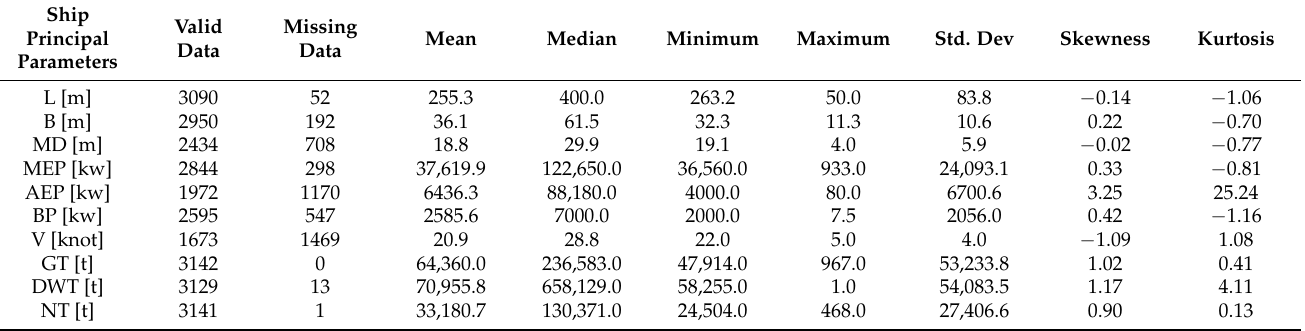
Table A1. Descriptive statistics of the main design parameters of 3142 container ships in ship static data.